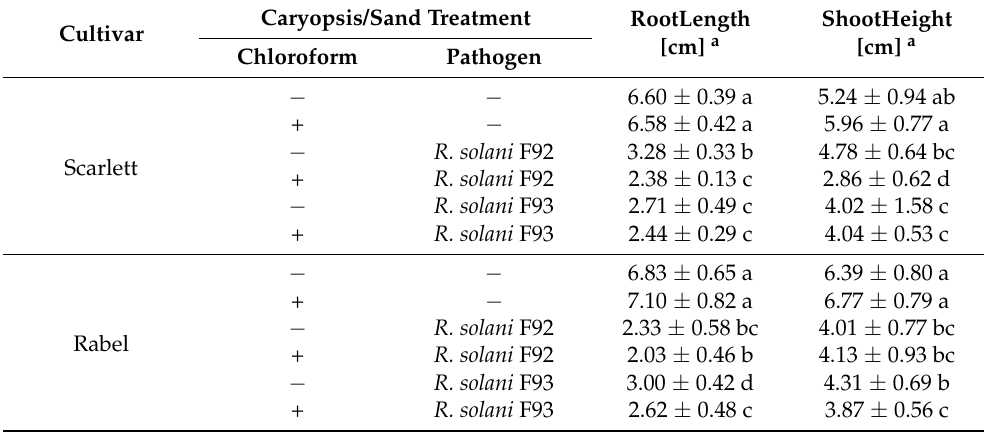
Table 1. The effect of chloroform treatment of barley grains on the growth of their seedlings in the presence of Rhizoctonia solani .